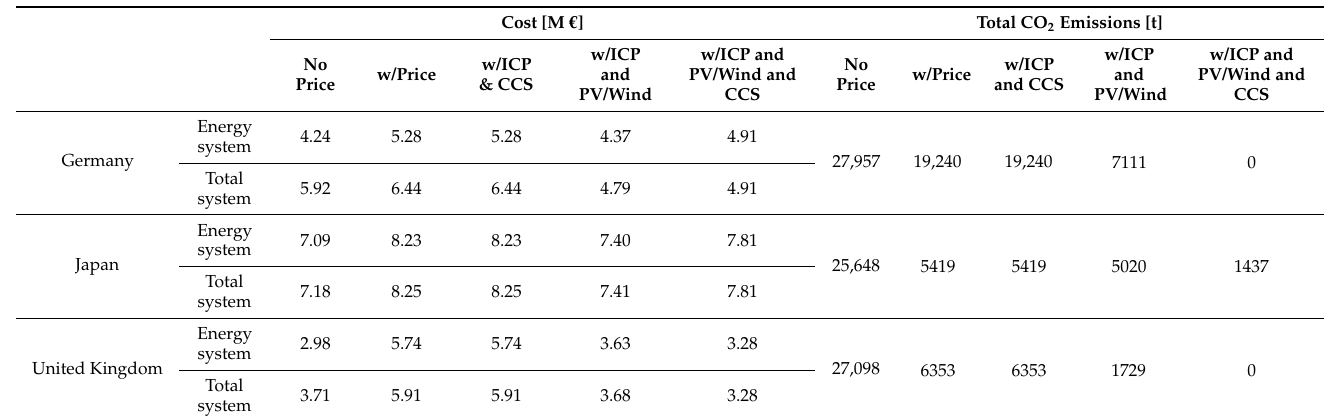
Table 10. Cost and emission overview.